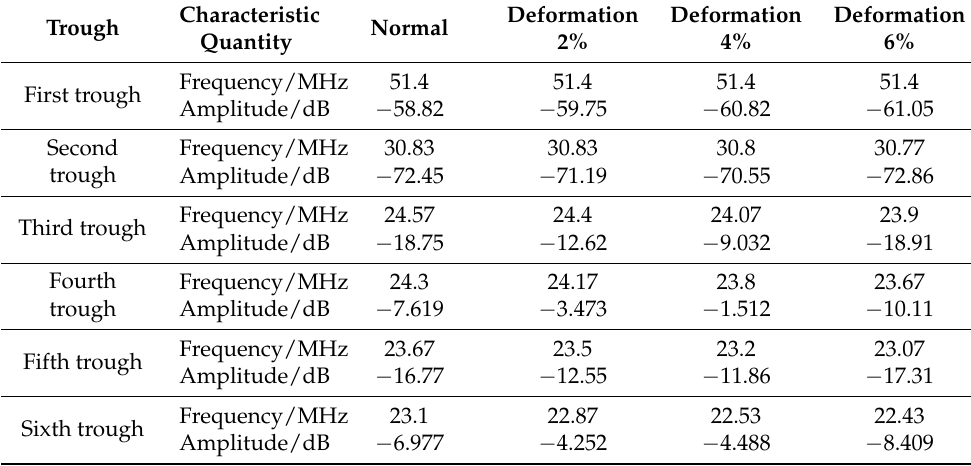
Table 7. Influence of winding radial deformation on frequency and amplitude of wave